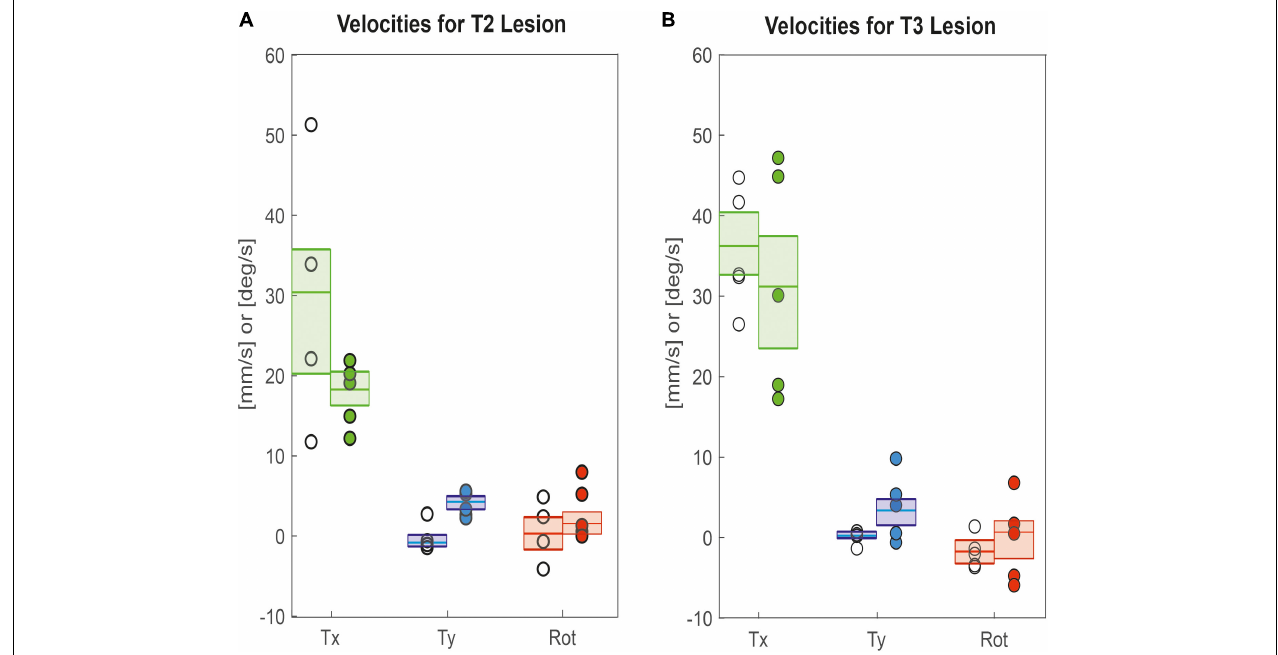
FIGURE 4 | Lesion effects on translational and rotational velocities. Tx: Forward translational velocity (green); Ty: Sideward translational velocity, with positive values indicating shifts to the left (blue); Rot: Rotational velocity, with positive values indicating ccw rotation (red). (A) Pro-to-mesothorax connective; (B) meso-to-metathorax connective. Symbols show median velocity per animal (lesion: filled circles; sham operation: open circles). Boxes comprise all trials of the cohort and show the median velocities and the bootstrapped 95% CI.